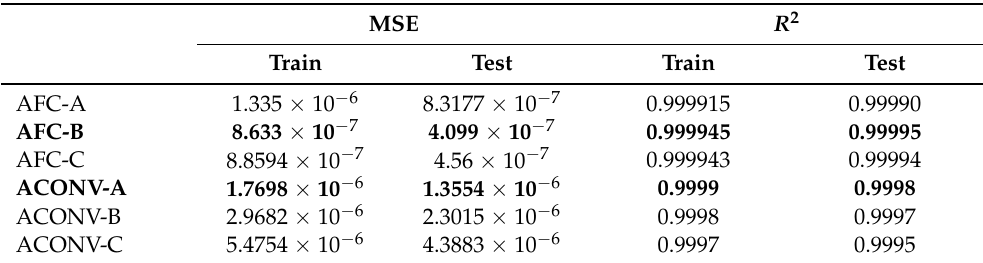
Table 6. Stacked autoencoder results for the dataset 2. The boldface indicates the best results.